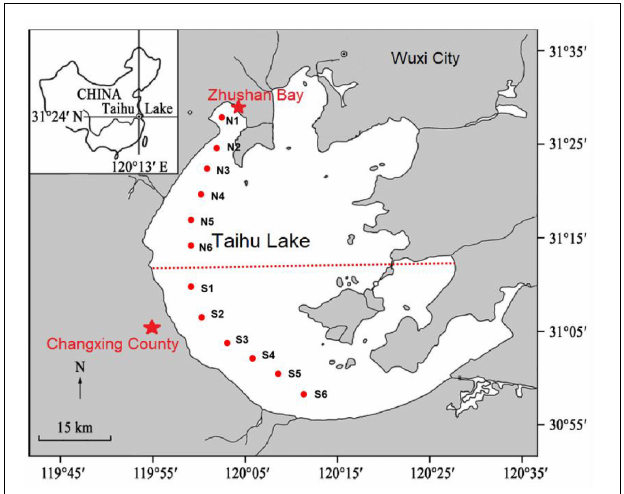
FIGURE 1 | Schematic diagram of sampling